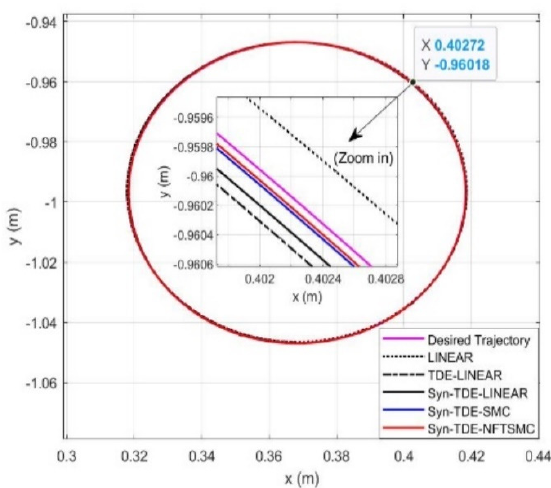
Figure 5. Trajectory tracking in X-Y plane (circular motion).